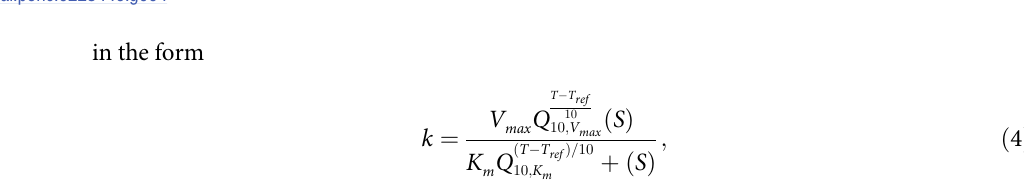
Fig 4. Rate of change in different dissolved organic carbon (DOC) molecular-size fractions. Molecular size decreases from DOC size1 to DOC size7 . DOC size1 and DOC size2 belong to high-molecular weight-DOC (HMW-DOC); the remainder belong to low-molecular-weight DOC (LMW-DOC). See Table 1 for abbreviations.